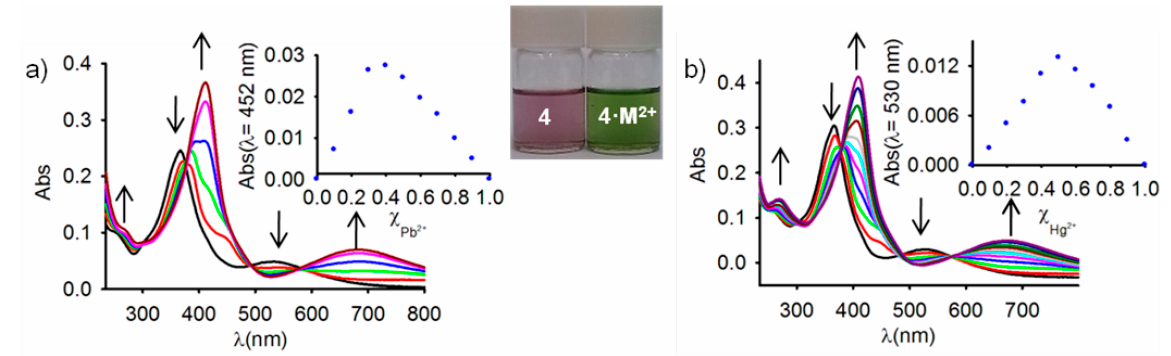
Figure 3. Evolution of the Uv-vis spectrum of 4 (c = 1 ⋅ × 10 − 4 M, in CH of increasing amounts of ( a ) Pb 2+ , and ( b ) Hg 2+ (c = 2.5 ⋅ × 10 − 2 M in CH The arrows indicate the absorptions that increase or decrease during the experiment. Inset: Job’s plots showing the 1:2 and 1:1 (M +2 /receptor) stoichiometries for the complexes formed with Pb 2+ and Hg 2+ , respectively.